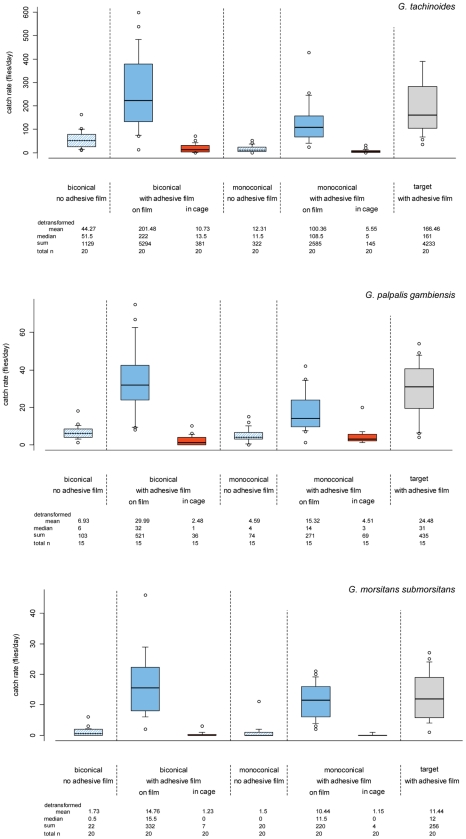
Daily catch rates of G. tachinoides (top), G. palpalis gambiensis (middle) and G. morsitans submorsitans (bottom) by traps and a target.The target and the cloth portions of traps were covered with adhesive film to compare the propensity of flies to land on these different devices. Catch rates of such traps were separated into fly catches on the cloth part and those trapped in the cage of the trap. Biconical and monoconical traps not treated with the adhesive film were included as controls. The limits of the boxes indicate the twenty-fifth and seventy-fifth percentiles; the solid line in the box is the median; the capped bars indicate the tenth and the ninetieth percentiles, and data points outside these limits are plotted as circles.